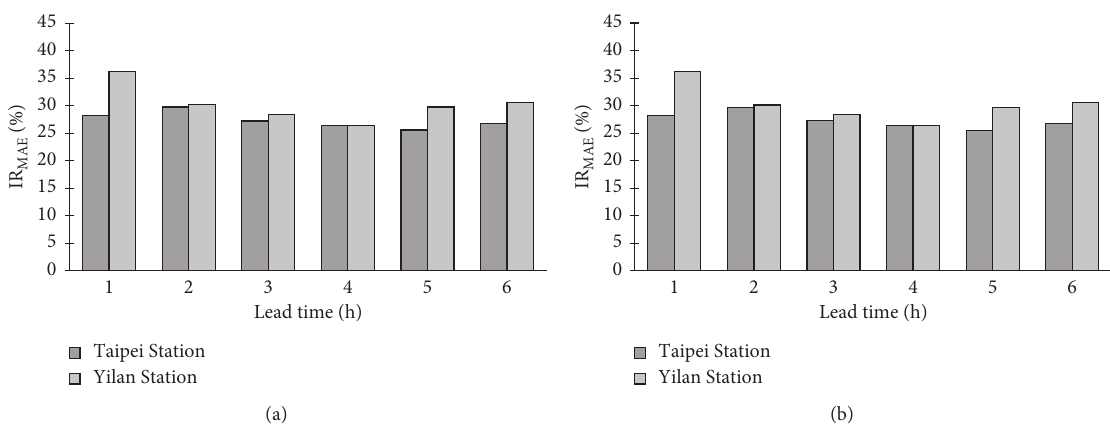
Figure 16: Improvement rate of predictive accuracy in terms of MAE and RMSE, comparing the use and nonuse of WRF simulation values for the Taipei and Yilan